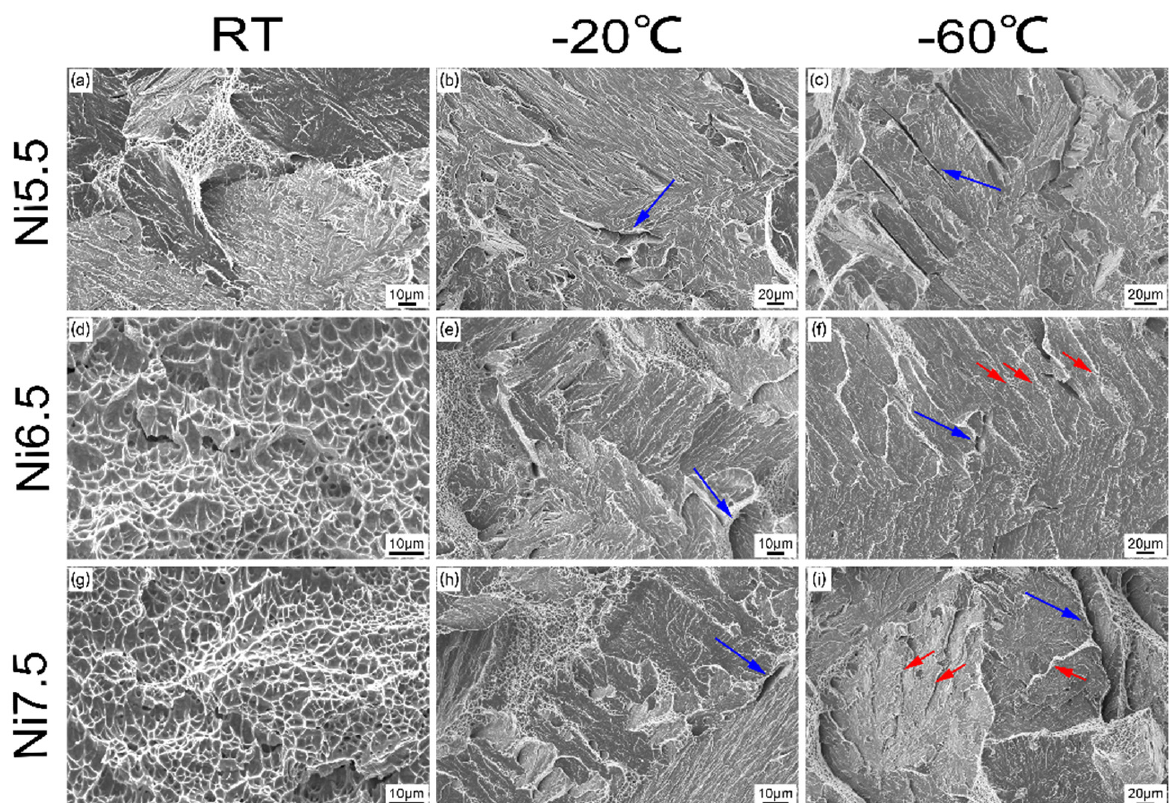
Figure 14. SEM micrographs of the fractured impact specimens. ( a – c ) are the fracture morphology of Ni5.5 at RT, − 20 °C, and − 60 °C, respectively; ( d – f ) are the fracture morphology of Ni6.5 at RT, − 20 °C, and − 60 °C, respectively; ( g – i ) are the fracture morphology of Ni7.5 at RT, − 20 °C, and − 60 °C, respectively; The blue arrow represents secondary cracks; the red arrow represents dimples be- tween the cleave plane).